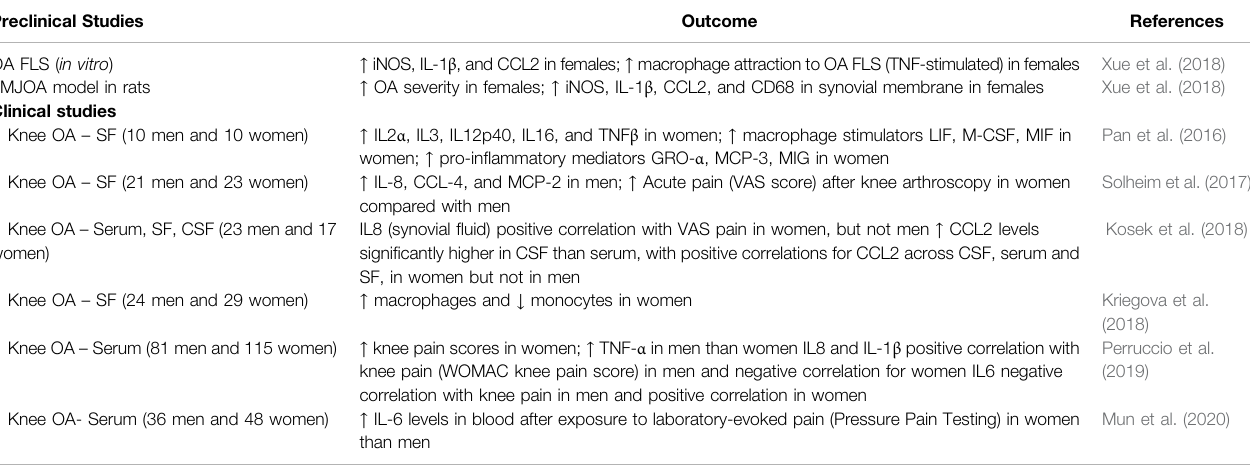
TABLE 1 | Main sex differences and OA association to innate immune system activation. Preclinical Studies Outcome